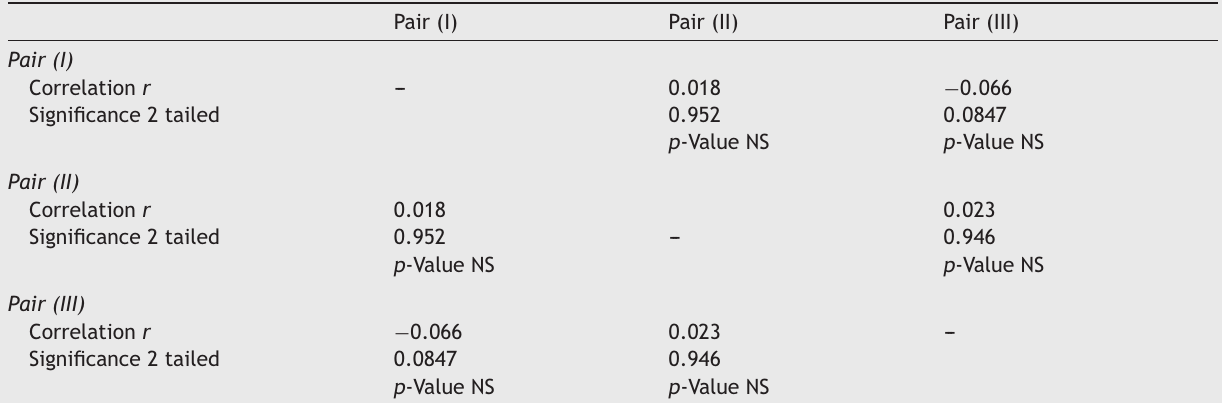
Table 2 The partial correlation between size of perforation and ABG improvement postoperatively between three groups.